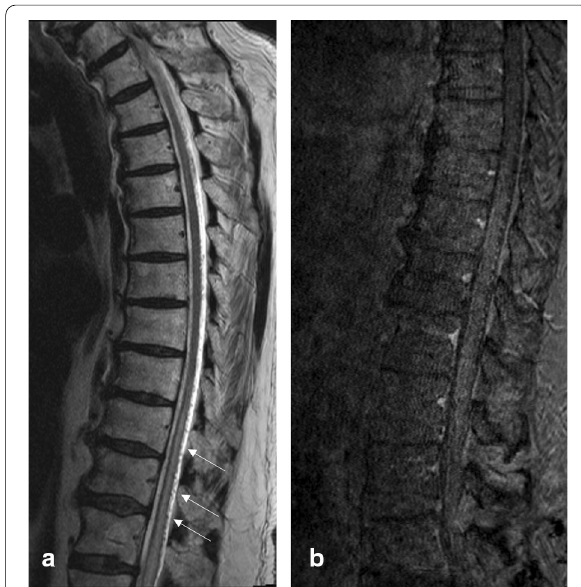
Fig. 2 Sagital T2W image ( a ) through the thoracic spine and post contrast sagittal image through the lumbar spine ( b ), clearly demonstrating numerous prominent vessels along the dorsal aspect of the cord (arrows), which were not seen on the prior study